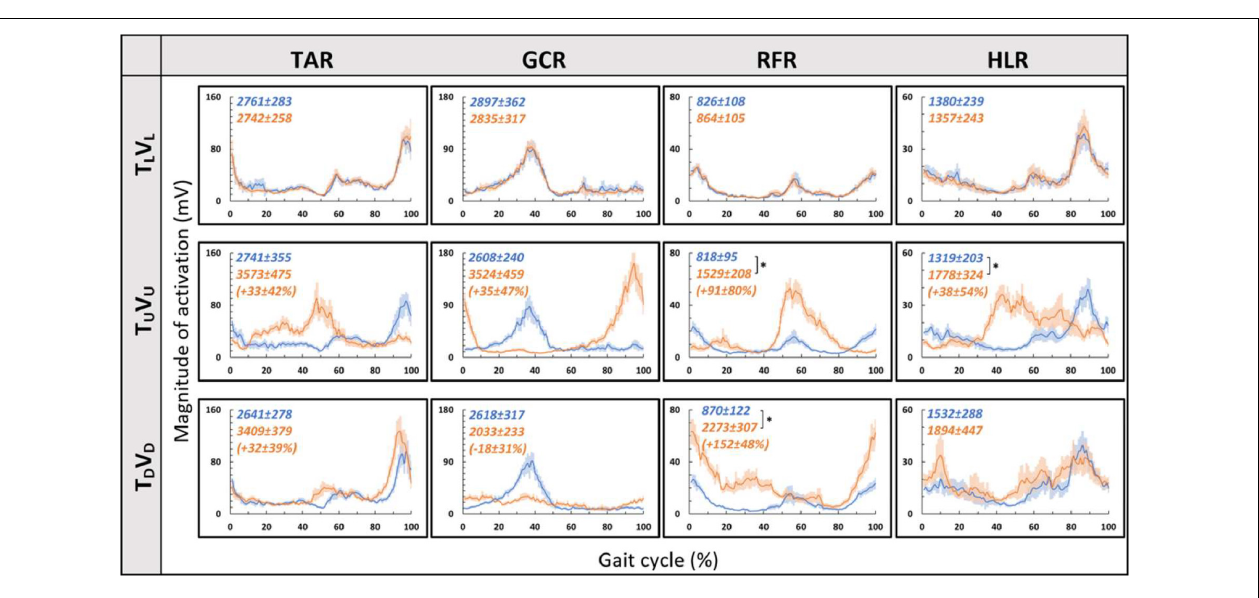
FIGURE 4 | Pre- vs. post-EMG muscle activation patterns for visual–physical congruent transitions. Grand averages (across participants, N = 12) of muscle activation patterns ( Y -axis, in mV) plotted against a time-normalized gait cycle on the X -axis (in % of the gait cycle) in blue (shaded areas represent SE) for pre-transition and in orange (shaded areas represent SE) for 20 s post-transition. Numerical values at the top left of each panel represent averaged summation (area under the curve) magnitude of activation ± SE for pre-transition (blue) and post-transition (orange); asterisks denote a significant post- vs. pre-transition change (two-tailed, paired t -test, * p < 0.0125) that appears below them (in %) in parentheses. Upper row displays pre- and post-transition leveled walking for each of the four muscles, and as expected, pre vs. post are comparable for each of the muscles. Note that in both uphill (middle row) and downhill (bottom row) transitions, the pre-transition (blue curve) is comparable to the leveled condition (blue in the upper row). Post-transition significant changes are evident for inclined transitions (uphill or downhill) for all four muscles apart from the HLR downhill transition (bottom right). TAR, tibialis anterior right; GCR, gastrocnemius right; RFR, rectus femoris right; HLR, hamstring lateralis right. See sections “Results” and “Materials and Methods” for more